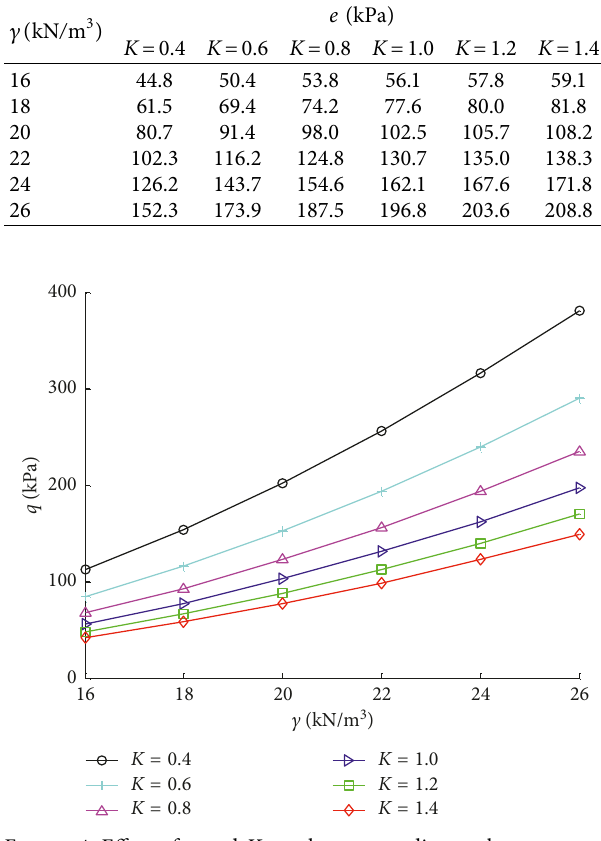
Figure 4: Effect of c and K on the surrounding rock pressure q